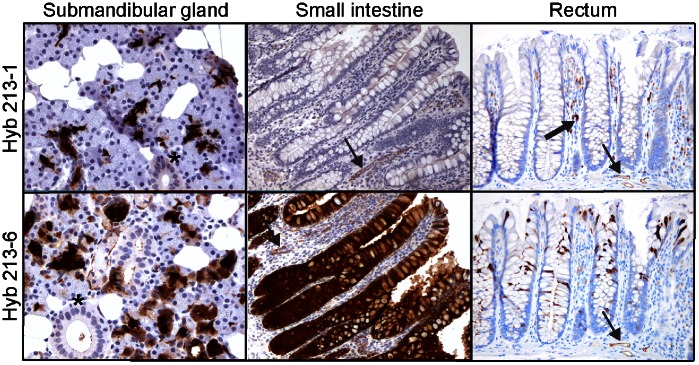
Immunohistochemical localization of DMBT1gp340 in human submandibular glands, small intestine and rectum.The tissues were stained using monoclonal antibodies Hyb213-1 or Hyb213-6 directed against DMBT1gp340 and an indirect immunperoxidase technique and counterstained with Mayer’s hematoxylin as described in the Materials and Methods section. A positive signal is shown by brown color. Asterisks show striated ducts. Thin black arrow shows stained endothelial cells. Thick black arrow shows a stained macrophage in the lamina propia Original magnification: 100×.